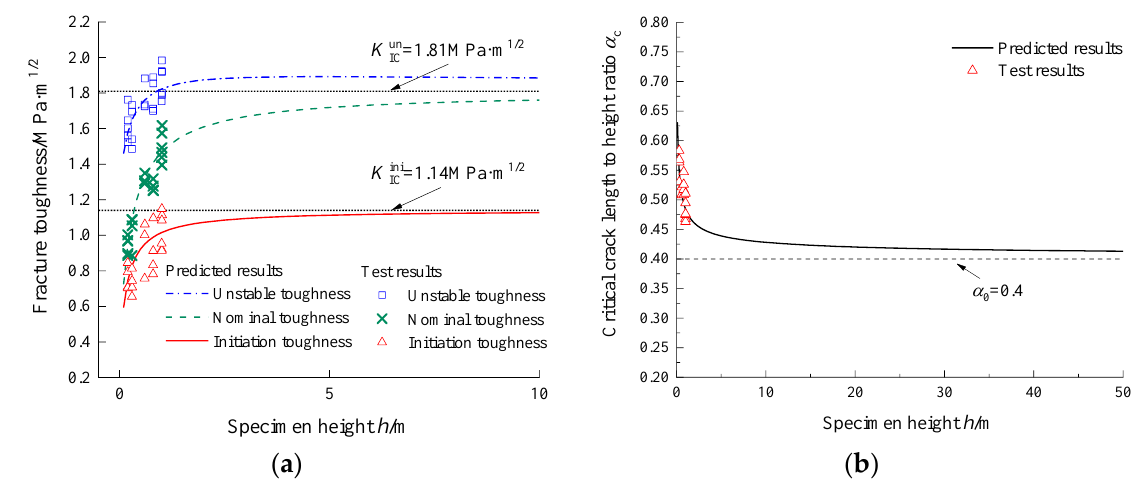
Figure 10. Fracture toughness and crack length-to-height ratio of specimens with different sizes: ( a ) fracture toughness; ( b ) critical crack length-to-height ratios. ( a ) fracture toughness; ( b ) critical crack length-to-height ratios.